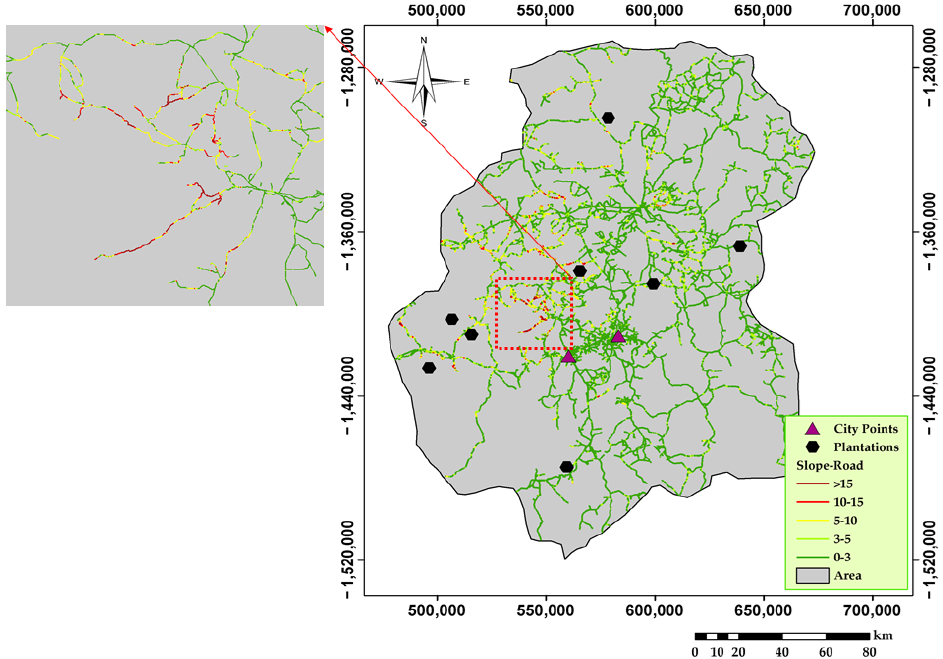
Figure 8. Identifying the potentially dangerous slopes on existing roads in Huambo